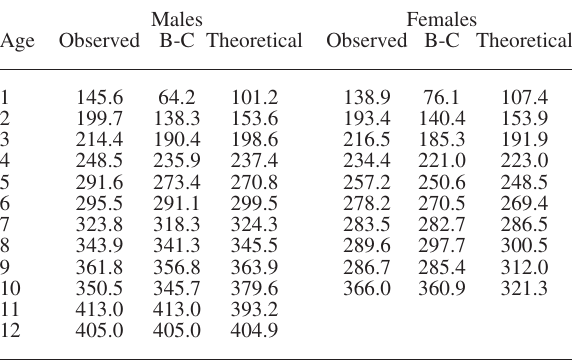
Table 3. – Mean observed, back-calculated (B-C) and theoretical total lengths for male and female H. didactylus sampled in the Bay of Cádiz between March 1999 and March 2000. Males